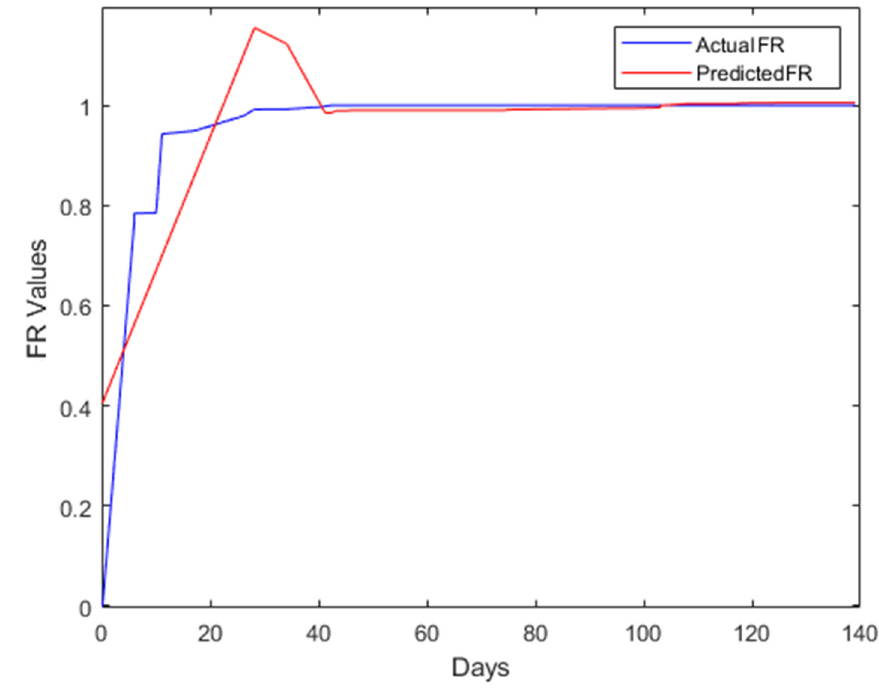
Figure 7. Graph of actual and regression normalized FR values (kaolin 4% Al).